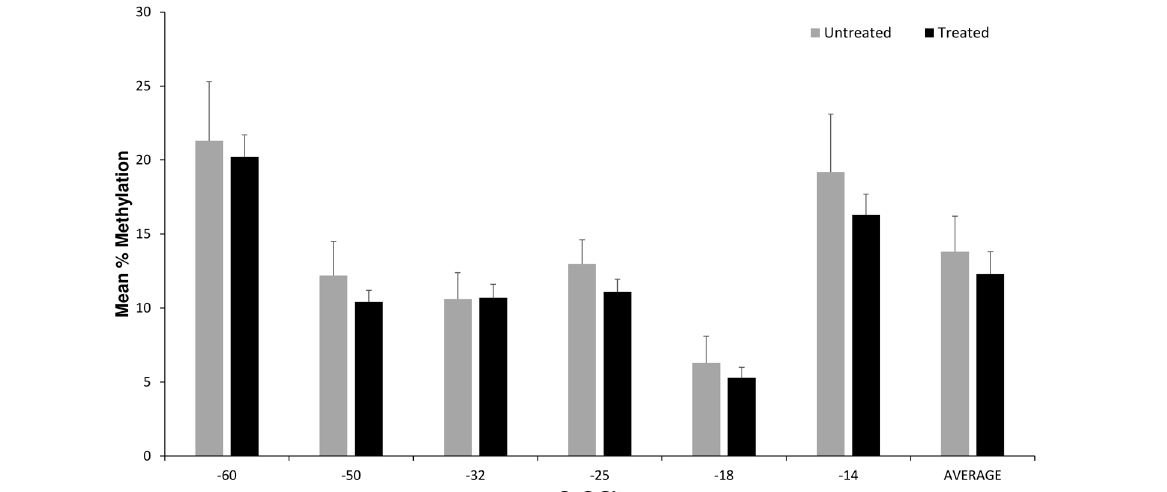
Figure 1. Placenta OPRM1 DNA methylation and NOWS pharmacologic treatment. Average placental OPRM1 methylation levels for CpG sites for the 64 opioid subjects based on NOWS pharmacologic treatment ( n = 49) versus no treatment ( n = 15). There were no statistically significant differences in univariate or multivariate Table 3. Association of placental OPRM1 methylation levels with NOWS outcomes CpG site Unadjusted results P -value univariate Adjusted results P -value multivariate